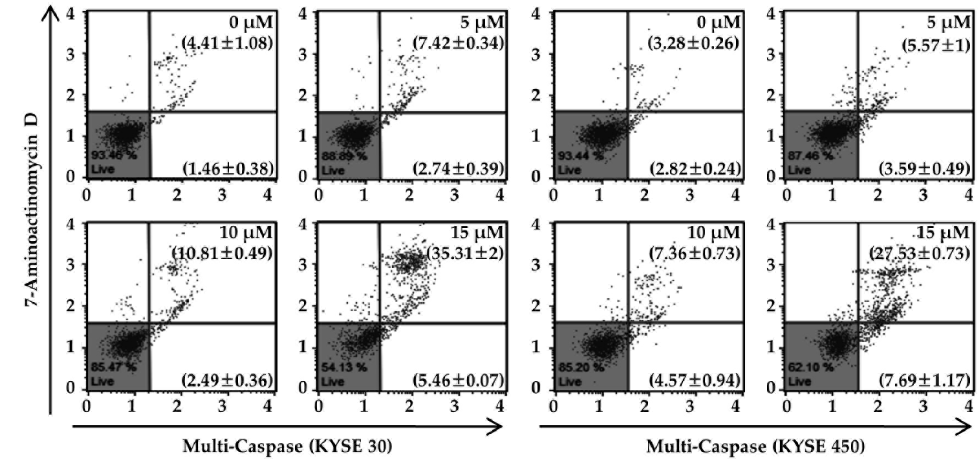
Figure 6. Effects of Ech on multi-caspases activity in KYSE 30 and KYSE 450 cells. After cells were treated with Ech at various concentrations for 48 h, percentages of KYSE 30 and KYSE 450 cells with caspases activities were assessed. X -axis means the degree of caspase activity and y -axis shows the fluorescence of 7-AAD. Each proportion in the figure represents multi-caspases positive / live cells (lower right) or multi-caspases positive / dead cells (upper right). All tests were performed in triplicate. Values are expressed as mean ± SD.